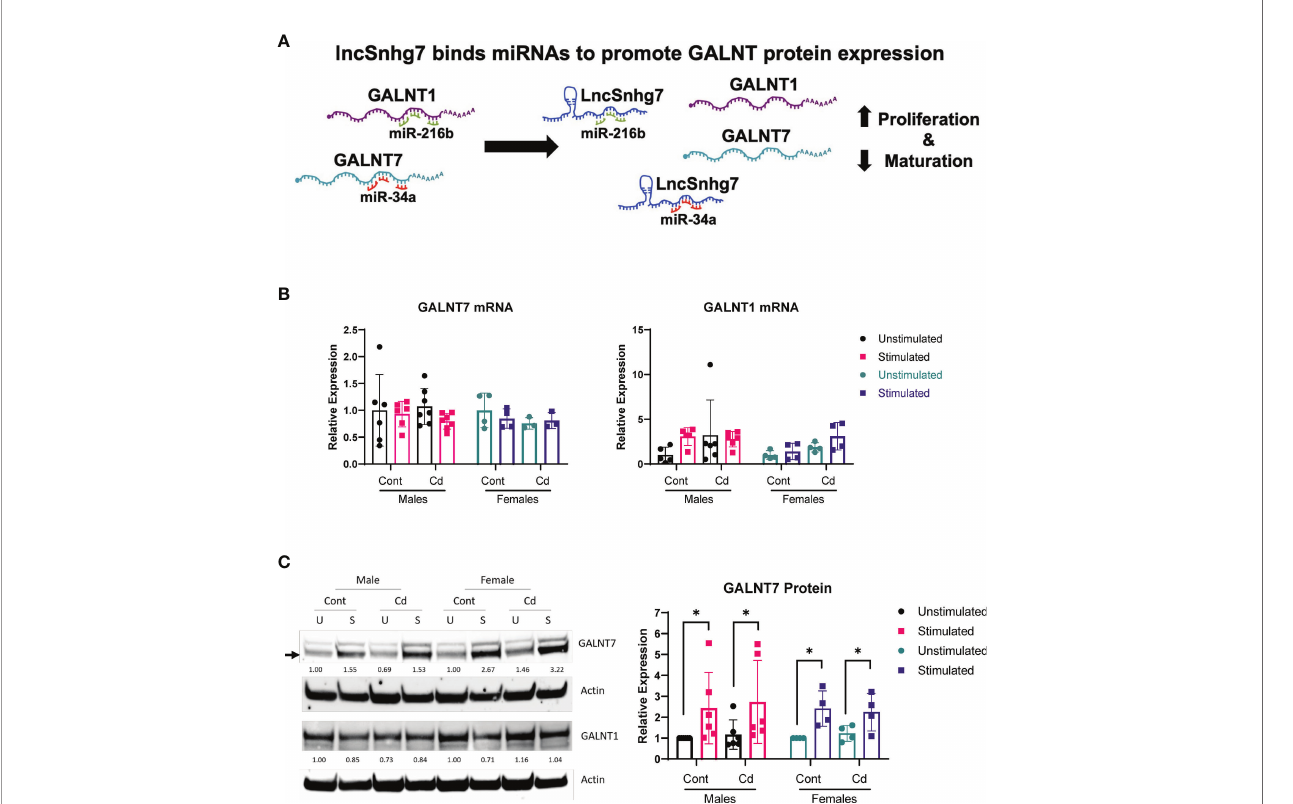
FIGURE 2 | GALNT7 protein expression, but not mRNA expression, is altered in CD4 + T cells following activation. (A) Model of GALNT1 and GALNT7 regulation by lncSnhg7. (B, C) CD4 + CD25 - T conventional cells were isolated from total splenocytes. Cells were cultured in the presence of anti-CD3/CD28 magnetic beads for 0 and 16 hours for RNA or 0 and 72 hours for protein. GALNT1 and GALNT7 expression was analyzed by qPCR (B) and western blot (C) . Statistical signi fi cance was assessed using ratio paired t-tests between stimulated and unstimulated samples with correction for multiple comparisons using the Holm-S ̌ ı ́ da ́ k method in post-hoc analysis. *p < 0.05. n = 3-7 per